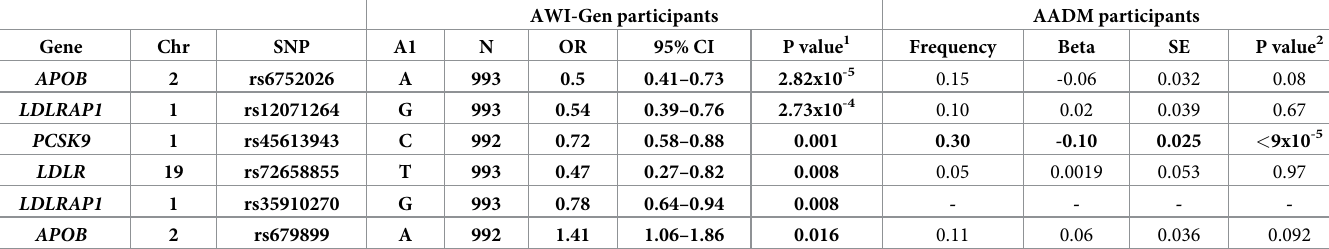
Table 4. Significant associations with LDL-cholesterol levels in the AWI-Gen cohort and replication in the AADM